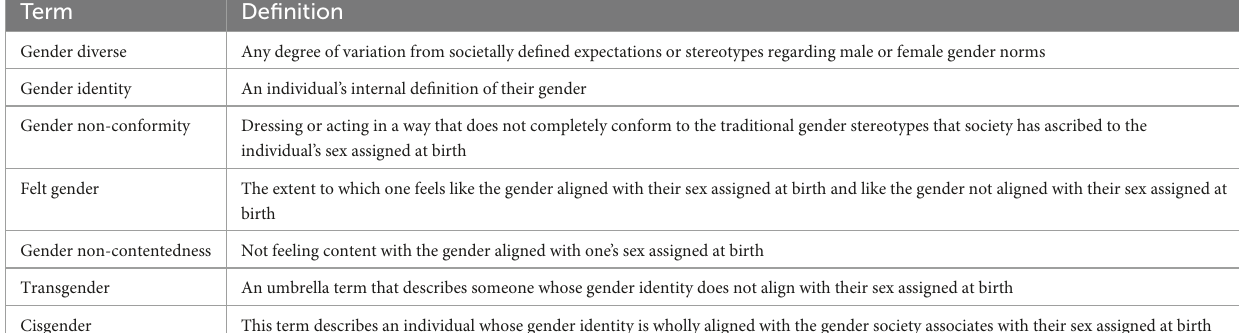
TABLE 1 Definitions of terms used in this